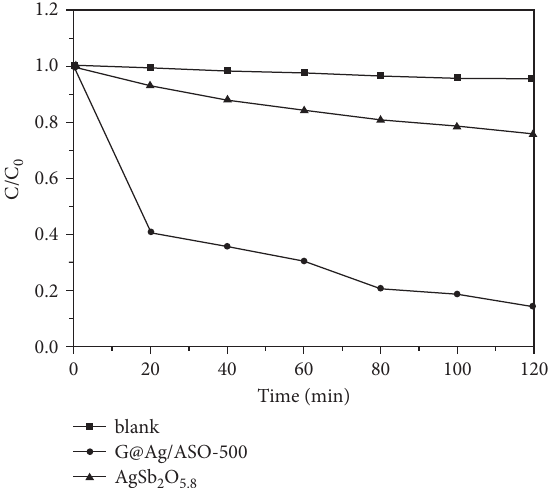
Figure 9: Photocatalytic degradation of